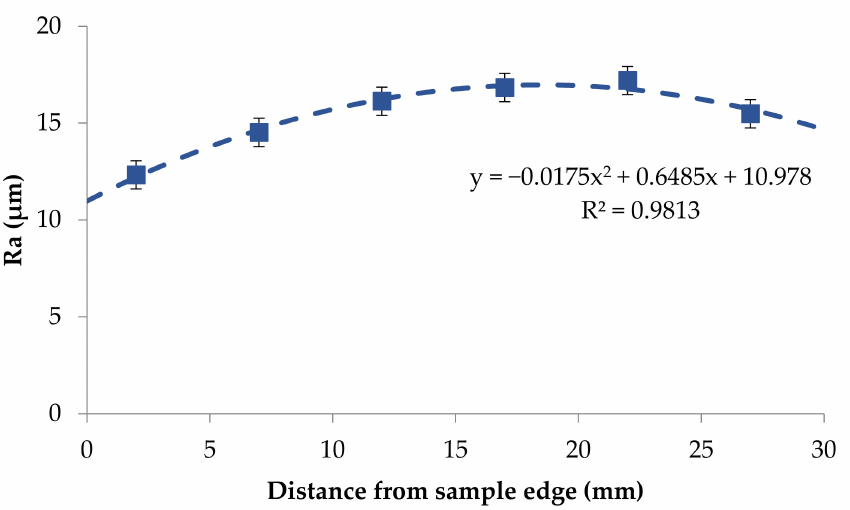
Figure 17. The relationship between the roughness average R a and the distance on the edge 2 on the briquette back surface—left to right